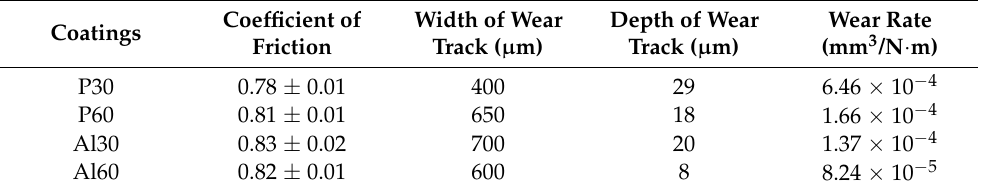
Figure 11. Friction coefficient as a function of sliding time under different loads for Al60 coating. 3.6. Corrosion Behavior of the PEO Coatings Figure 12 displays the potentiodynamic polarization curves that were carried out in the 5 wt % NaCl (pH = 3.1–3.3) corrosive media after OCP stabilization. The corrosion potential (E corr ) and current density (i corr ) of the 6061 Al alloy and PEO coatings obtained from Figure 12 are listed in Table 2. As we can see from Figure 12, the PEO coatings have much lower i corr and more positive E corr than the Al alloy substrate, indicating that the PEO coatings improve the corrosion resistance of Al alloy. For the PEO coatings, the E corr has a positive shift, and the i corr decreases with the treatment time increasing. According to Ta- ble 2, the P60 coating shows the lowest corrosion current density (1.09 × 10 − 7 A·cm − 2 ). Therefore, the P60 coating exhibits the best corrosion resistance compared to those other coatings in acidic solution according to the potentiodynamic polarization results.